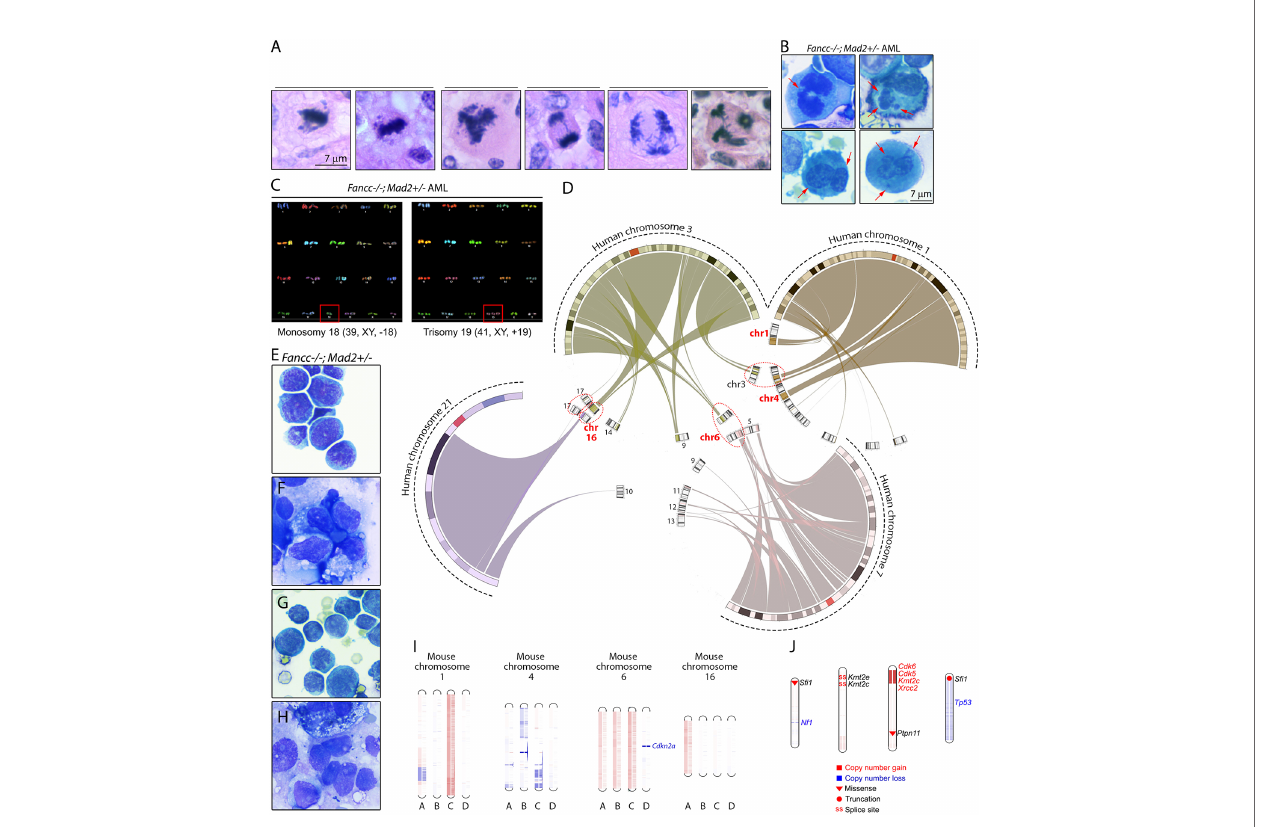
FIGURE 6 | Mitotic in fi delity and genomic lesions in Fancc-/-; Mad2+/- malignancies. (A) Representative images of abnormal mitotic fi gures in Fancc-/-; Mad2+/- hematopoietic malignancies in situ and (B) in bone marrow cytospins. Red arrows indicate lagging anaphase chromosomes, multi-nucleation and bi-nucleation in bone marrow cells isolated from Fancc-/-; Mad2+/- AML mice. (C) SKY analysis of Fancc-/-; Mad2+/- leukemia shows clonal hematopoiesis with whole- chromosome gains and losses. (D) Circular synteny map shows mapping of human chromosomes 1, 3, 7 and 21, whose changes had been implicated in FA MDS/ AML in previous studies, to mouse chromosomes. Mouse chromosomes containing regions of more than one of the four human chromosomes are highlighted in circles. (E – H) Representative images of Fancc-/-; Mad2+/- malignancies. (I) Whole-exome sequencing of four Fancc-/-; Mad2+/- malignancies revealed copy- number variations of mouse chromosomes 1, 4, 6 and 16. Unique Fancc-/-; Mad2+/- malignancies are represented by letters A-D. Red denotes ampli fi cations and blue represents copy number losses. Additional somatic variants of genes implicated in human cancer and genome stability identi fi ed by WES in Fancc-/-; Mad2+/- malignancies are shown in (J) . Types of mutations are shown in the visual legend.